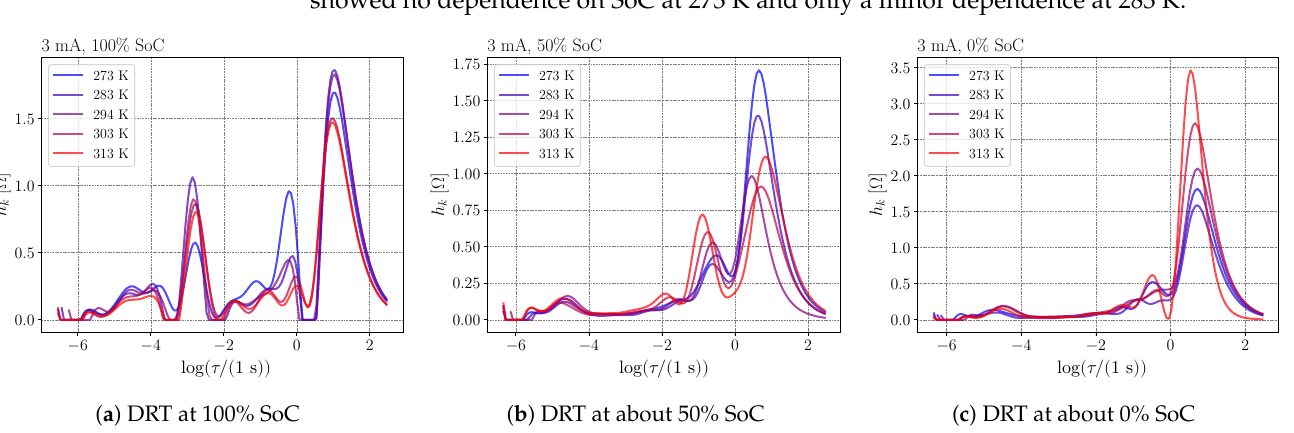
Figure 12. Influence of temperature at different SoCs and a discharge current of 3